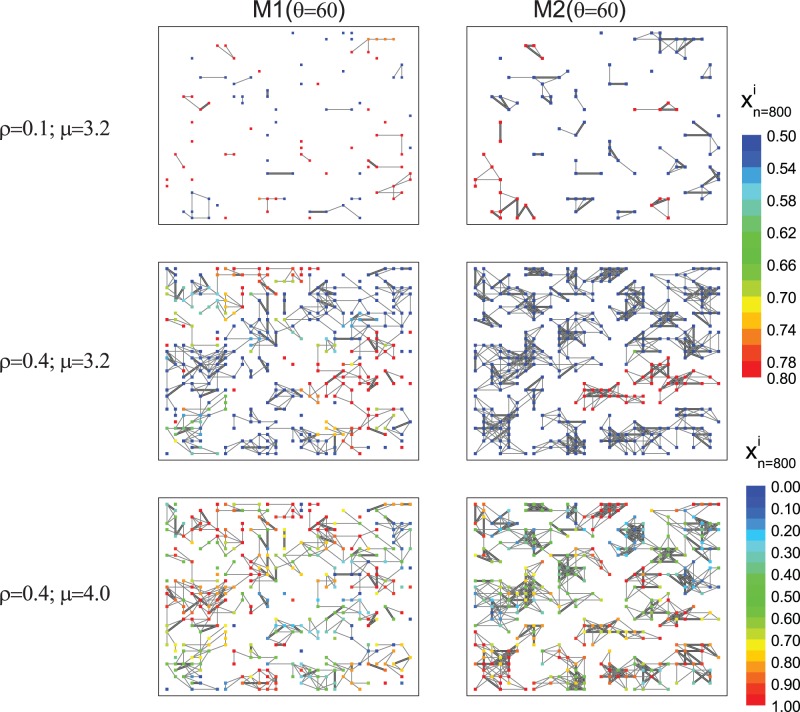
(Color online) Spatial distribution at time n = 800 for M1 and M2.Each dot represents one individual, whose claw displacement value,, is identified by the color scale on right of the graphs. Links shows the presence of interactions. Narrow lines means that the interaction occurs in just one direction (the interaction direction is not plotted) and wide lines means bidirectional interaction. The imposed density values, ρ = {0.1, 0.4}, and the logistic map values, µ = {3.2, 4.0} are shown on left of each graph. For all graphs the coupling constant value was set on D = 0.5. In order to contrast the spatial interaction network predicted by M1 and M2, in these graphs the spatial positions of the crabs are the same (for a given density), the unique difference is the orientation.